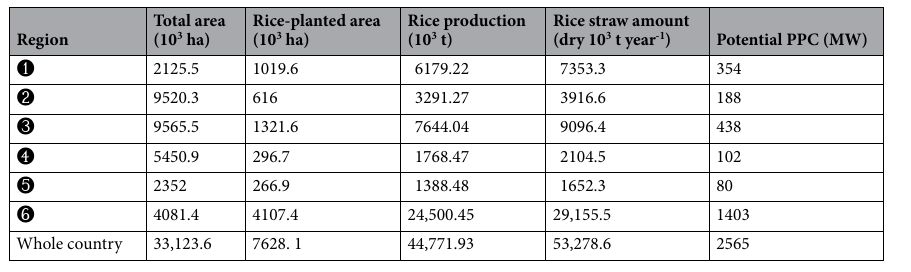
Table 2. Regional distribution and available rice straw residue in Vietnam.